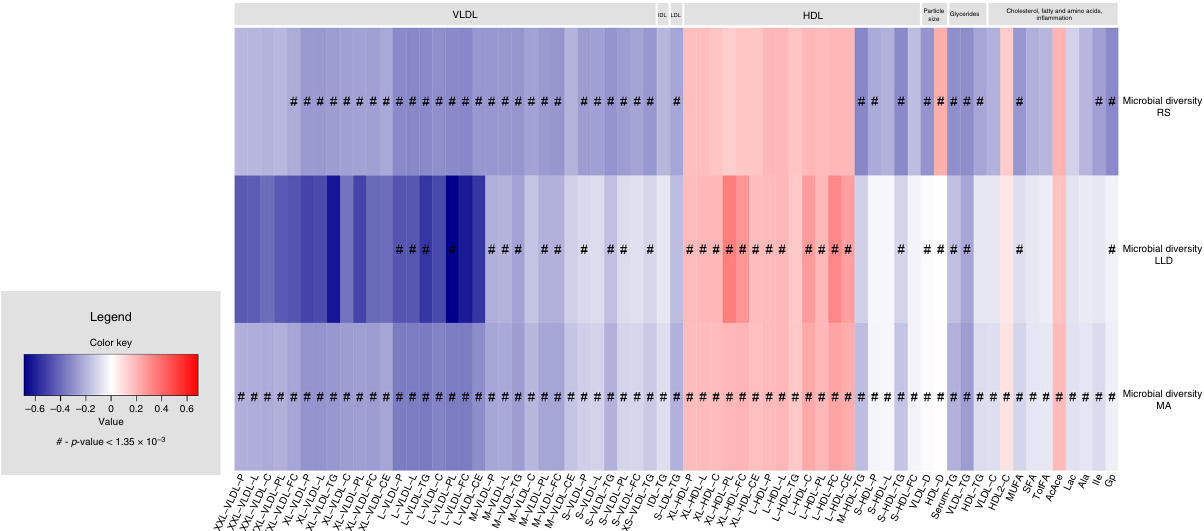
Fig. 2 Results of association analysis between metabolites and alpha diversity ( n = 2309). Metabolites are displayed on x -axis whereas microbial diversity in the RS, LLD, and combined meta-analysis is shown on y -axis. Lipoprotein classes, include very-low-density lipoprotein particles (VLDL), low- density lipoprotein particles (LDL), and high-density lipoprotein particles (HDL) of very low (XS), low (S), medium (M), large (L), very large (XL), and extremely large (XXL) size. The colors represent effect estimates. Blue color stands for inverse association. Red color denotes positive associations. Symbols on the plot represent level of signi fi cance with hash denoting Bonferroni signi fi cant